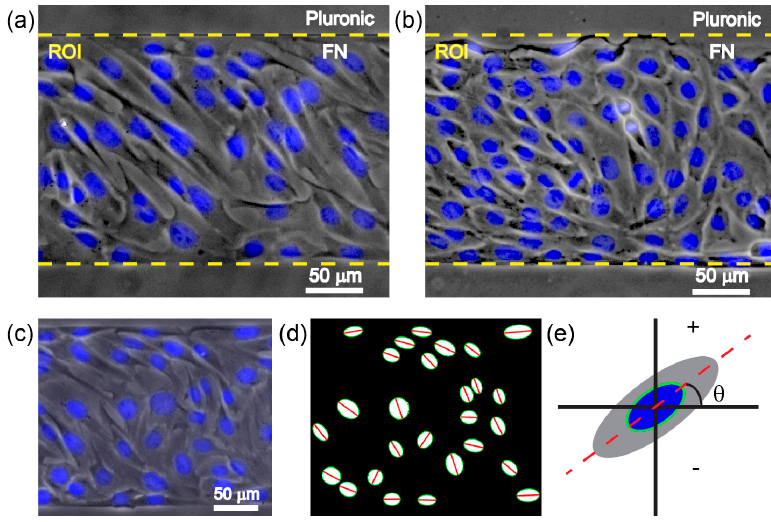
Figure 1. Schematic showing the definition of cell orientation in micropatterned stripes. ( a , b ) On a rigid substrate ( a , glass) or a soft substrate ( b , polydimethylsiloxane (PDMS), ratio of elastomer to cross-linker = 10:1), phase contrast microscopy showing C2C12 cells with 4 ′ ,6-diamidino-2-phenylindole (DAPI) nuclei staining cultured in micropatterned fibronectin (FN) stripes spaced by pluronic stripes; ( c ) phase contrast microscopy of C2C12 cells with DAPI nuclei staining, demonstrating that the long axis of the cell nucleus is aligned with the long axis of the spindle-shaped cell; ( d ) processed image of DAPI nuclei staining showing cell orientations. The green ellipse boundary shows the outline of the cell nuclei, and the red line shows the long axis of the cell nuclei; ( e ) the angle θ between the long axis of the cell nuclei and the horizontal axis aligned with the stripe boundary, which is defined as a positive value when the acute angle θ is within [0, 90] and as a negative value when the acute angle θ is within [ − 90, 0]. By counting the percentage of negatively and positively oriented cells in each stripe, the chirality is revealed when the difference between those percentages from multiple stripes is statistically significant.